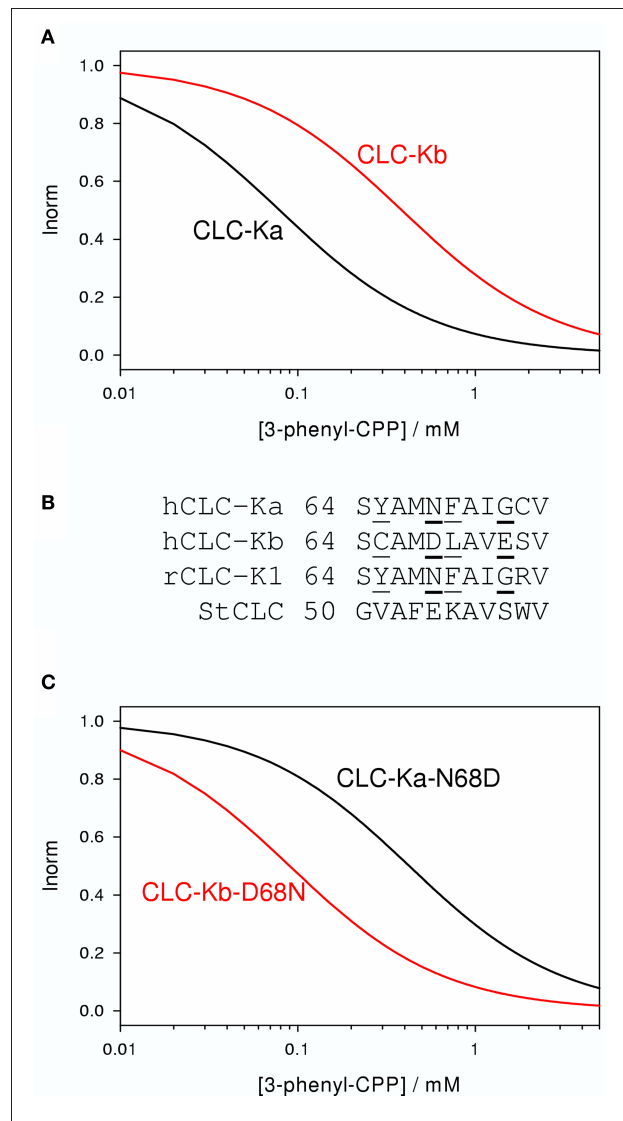
Figure 4 | effect of 3-phenyl-CPP on CLC-Ka, CLC-Kb, and mutants. (A) The blocking effect of 3-phenyl-CPP is schematically indicated for CLC-Ka and CLC-Kb. (B) A sequence alignment of a short stretch of residues of helix B of CLC-Ka, CLC-Kb, CLC-K1, and StCLC, a bacterial homolog (Dutzler et al., 2002) is shown. Residues which are identical in CLC-Ka and CLC-K1, and different in CLC-Kb, are underlined. CLC-K residues at position 68 drastically affect block by 3-phenyl-CPP. DIDS block is additionally dependent on the residue at position 72. Sequence of the bacterial StCLC is shown because the mutagenesis work was guided by the crystal structure of this protein. Residues at positions 68 and 72 are mostly responsible for the difference between CLC-Ka and CLC-Kb and are shown in bold. (C) Schematically the blocking effect of 3-phenyl-CPP of mutants CLC-Ka-N68D and CLC-Kb-D68N. Plots were generated based on data from Picollo et al.